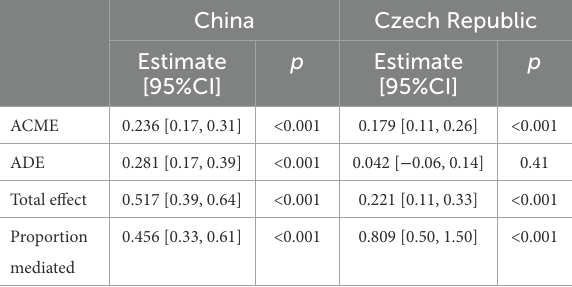
ACME – Average Causal Mediated Effect, ADE – Average Direct